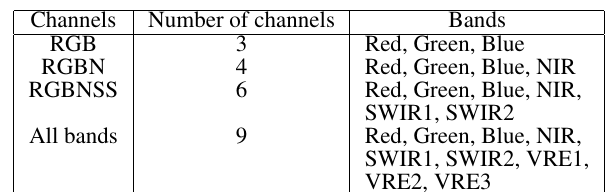
Table 3. Band combinations.